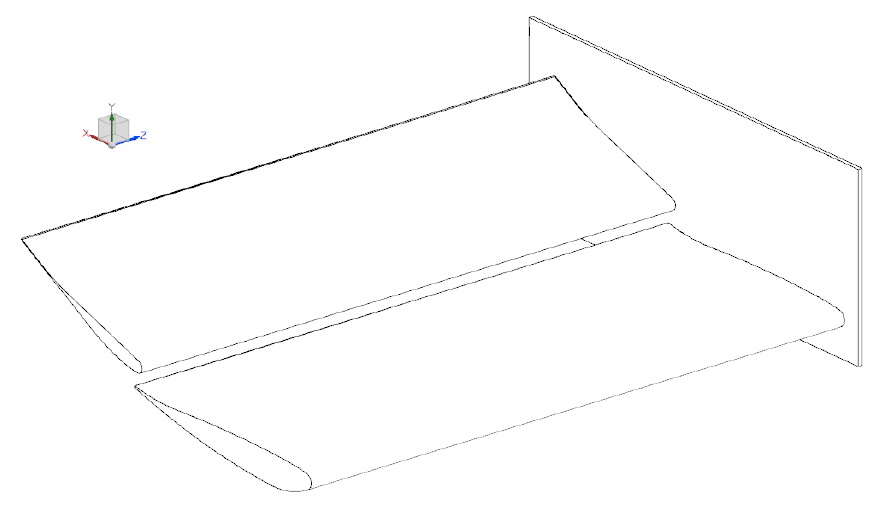
Figure 3. Two-element wing used for numerical simulations.